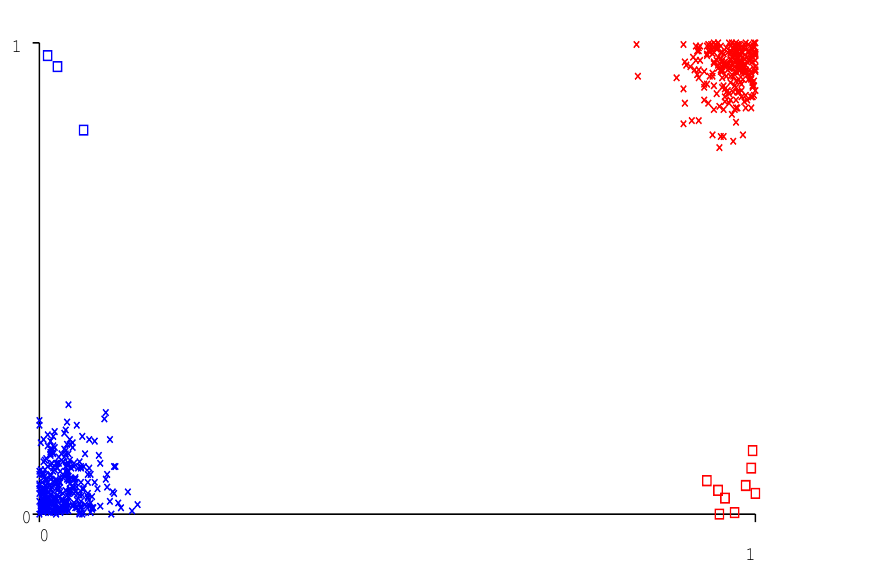
Figure 9. Classifier errors plot of rotation forest ensemble. From Figure 9, the squares indicate incorrectly classified instances, and the cross marks denote correctly classified instances. The three blue squares indicate that three instances are incorrectly predicted as the presence of heart disease, and the nine red squares signify the nine instances are incorrectly predicted as the absence of heart disease. The blue cross marks indicate the instances that are correctly classified as the absence of heart disease, and the red cross marks imply the instances that are correctly classified as the presence of heart disease. The ROC plot of the Rotation Forest ensemble after optimization is shown in Figure 10.